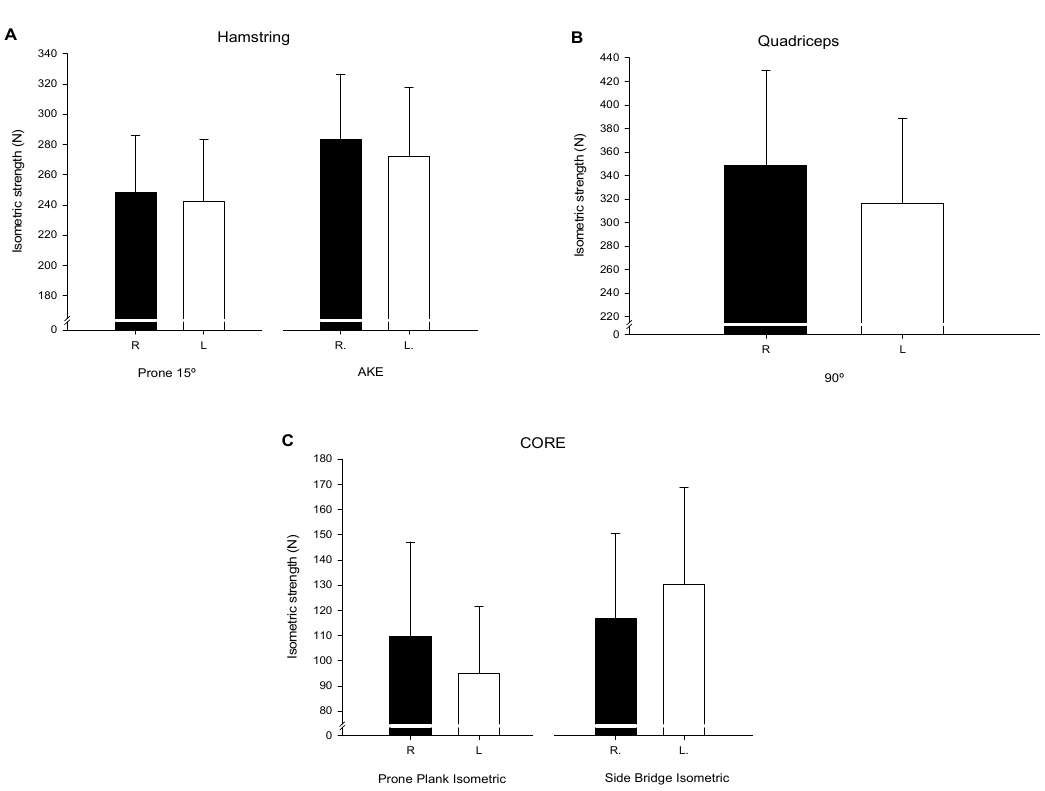
Figure 2. Results of Quadriceps ( A ), Hamstring ( B ) and core ( C ) muscles forces for both right (R) and left (L) leg.